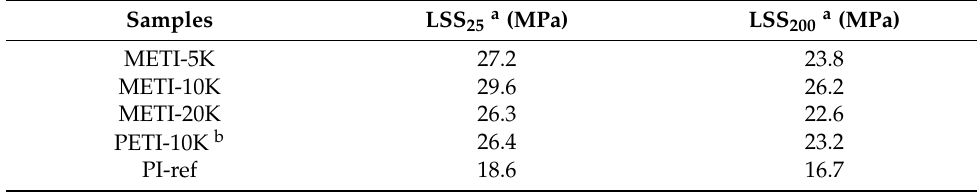
Table 4. Bonding strength of METI NFM